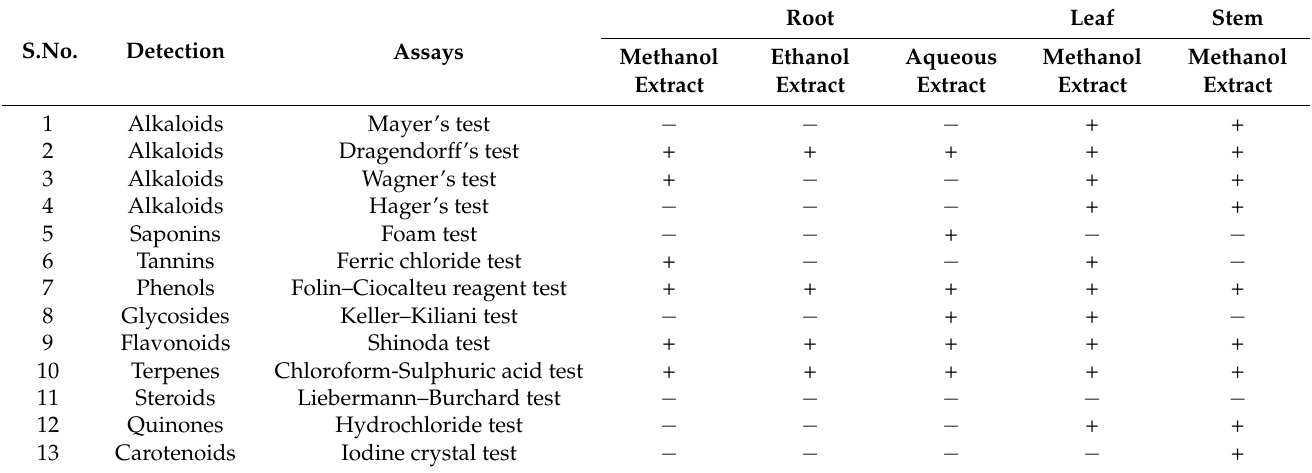
Table 2. Phytochemical screening of root, leaf and stem extracts of R. cordifolia .